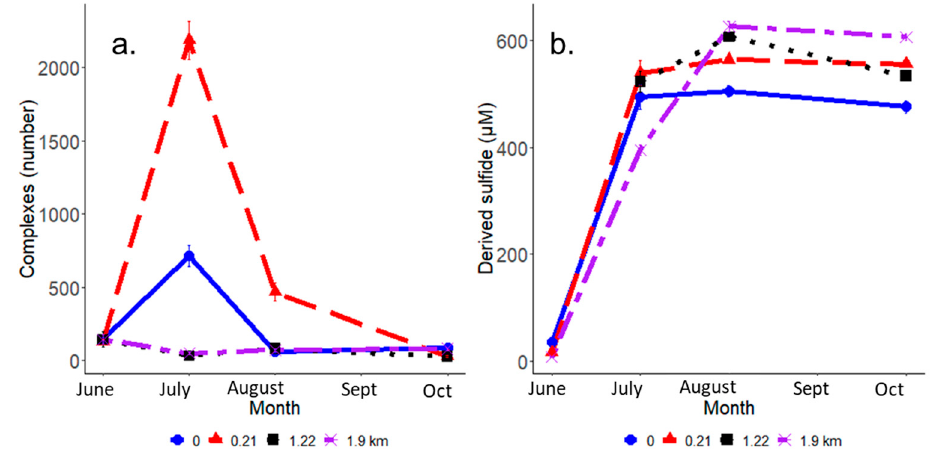
Figure 5. IRIS plate derived patterns in ( a ) the number of complexes per 45 cm 2 and ( b ) the calculated sulfide concentration ( µ M sulfide) averaged across each plate across wetland distance (km) and per month. Values are an average across the total 3 × 15 cm plate, averaging all white, grey, and black spaces. Error bars denote standard errors.